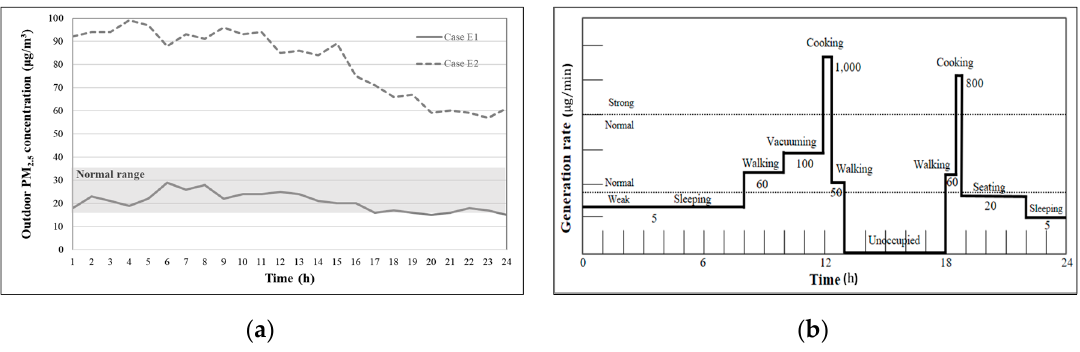
Figure 14. Indoor and outdoor particle conditions for the cases: ( a ) Outdoor PM2.5 concentration of cases E1 and E2; ( b ) schedule of the indoor PM2.5 generation rate. Table 7. Simulation cases.